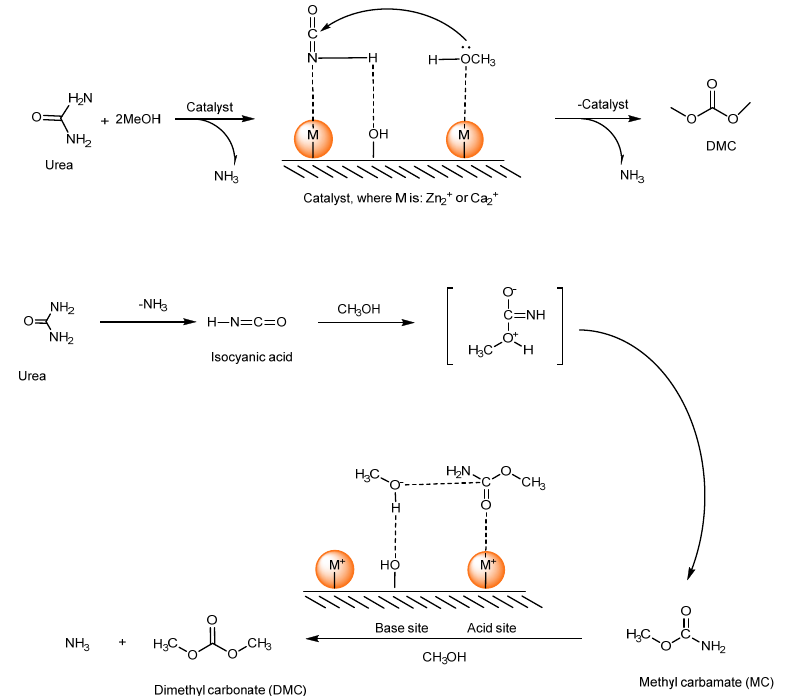
Figure 12. Most common reaction mechanism for the conversion of urea and methanol to DMC.